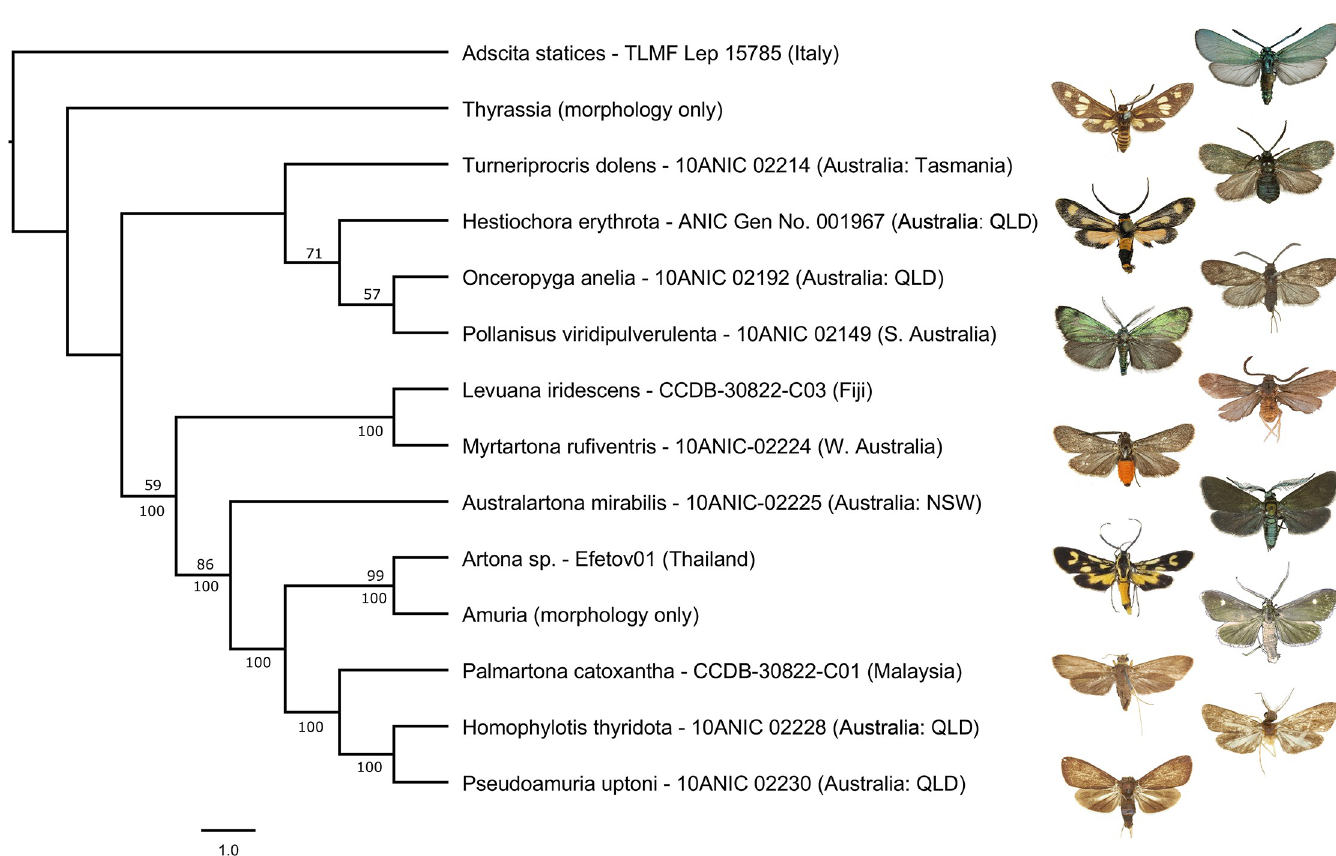
Fig 3. PAUP Maximum Likelihood tree from analysis of combined data (DNA + morphology). Values above branches are bootstrap support, values below branches are 50% majority rule of 5 equally parsimonious